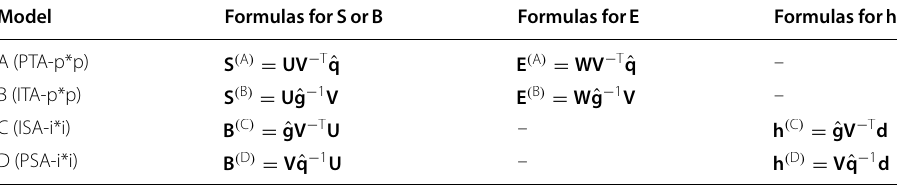
The superscript − 1 indicates inversion; the superscript − T indicates transposition and inversion; the hat ( ˆ x ) on top of a vector indicates diagonalization into a square matrix